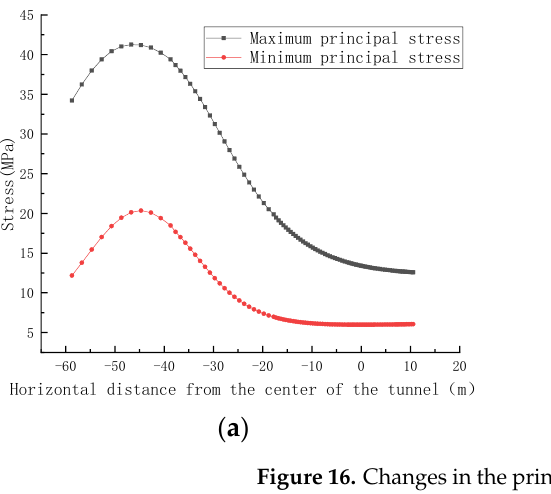
( b ) Figure 18. Principal stress distribution contour of the roadway ’s surrounding rock when the coal column is 8 m. ( a ) σ 1 cloud. ( b ) σ 3 cloud. The stress change curve shows (Figure 19) that, along the horizontal direction, the stress peak directly below the residual coal pillar is reached, and after moving away from the residual coal pillar, σ 1 and σ 3 gradually decrease, and σ 1 / σ 3 gradually decrease. Along the vertical direction, σ 1 first increases and then decreases as it moves away from the cen- ter of the roadway, while σ 3 gradually decreases. σ 1 at the center of the roadway is about 14 MPa, and σ 3 is about 6 MPa.